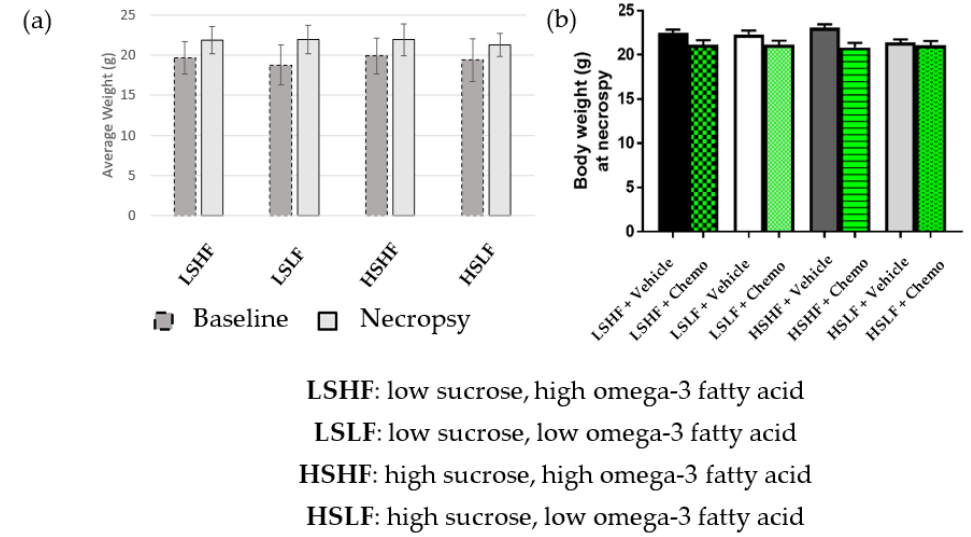
Figure 1. ( a ) Body weight of mouse diet cohorts at diet implementation and necropsy by diet only; ( b ) necropsy body weight of mouse diet cohorts by chemotherapy or saline vehicle treatment.